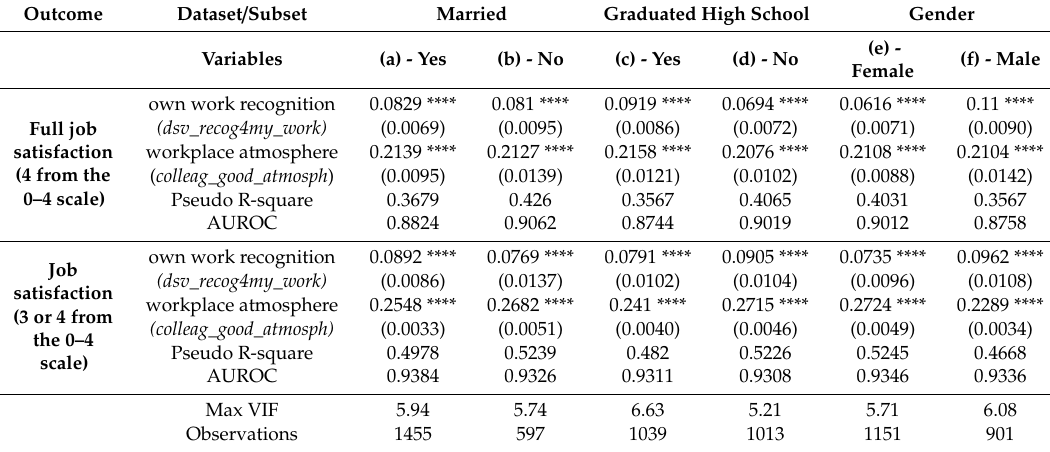
Table 1. The first round of robustness checks (respondent type) for both components of the core, as average marginal e ff ects on job satisfaction based on binary logistic regressions for both forms of the